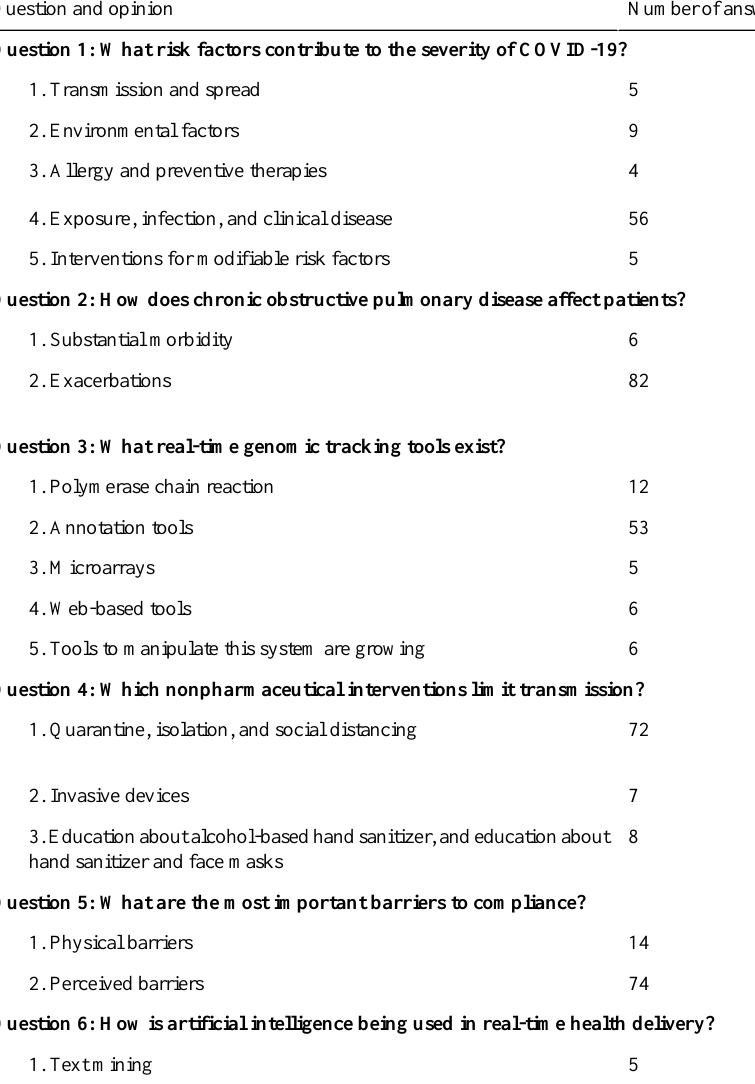
fectious diseases Necessary44. Reactive. It is necessary to understand the complexity and interac- tions of integrated environmental health risks assay a Number of answers classified to each opinion (ie, in each k-means cluster). b N/A: not